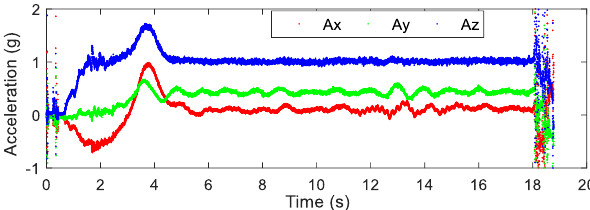
Figure 14. Output data of the three-axis accelerometer.